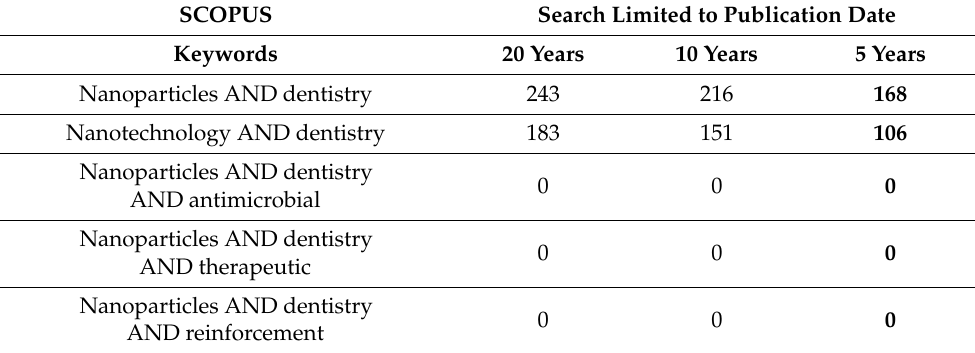
Table 3. Compilation of topic-related articles found in SCOPUS database (data from 2 months were not available in the